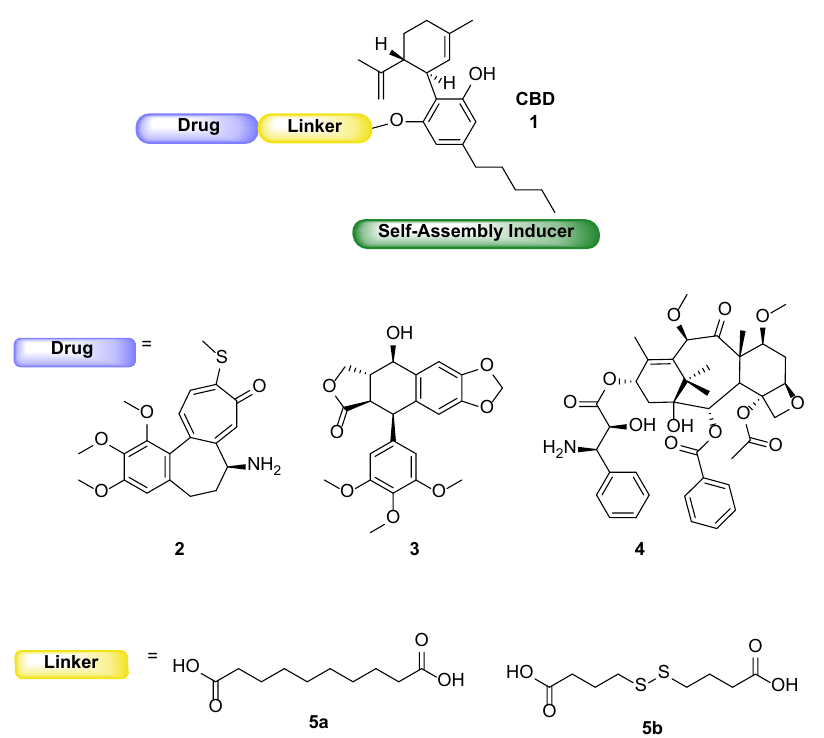
Figure 1. Schematic structure of the drug conjugates and building blocks.